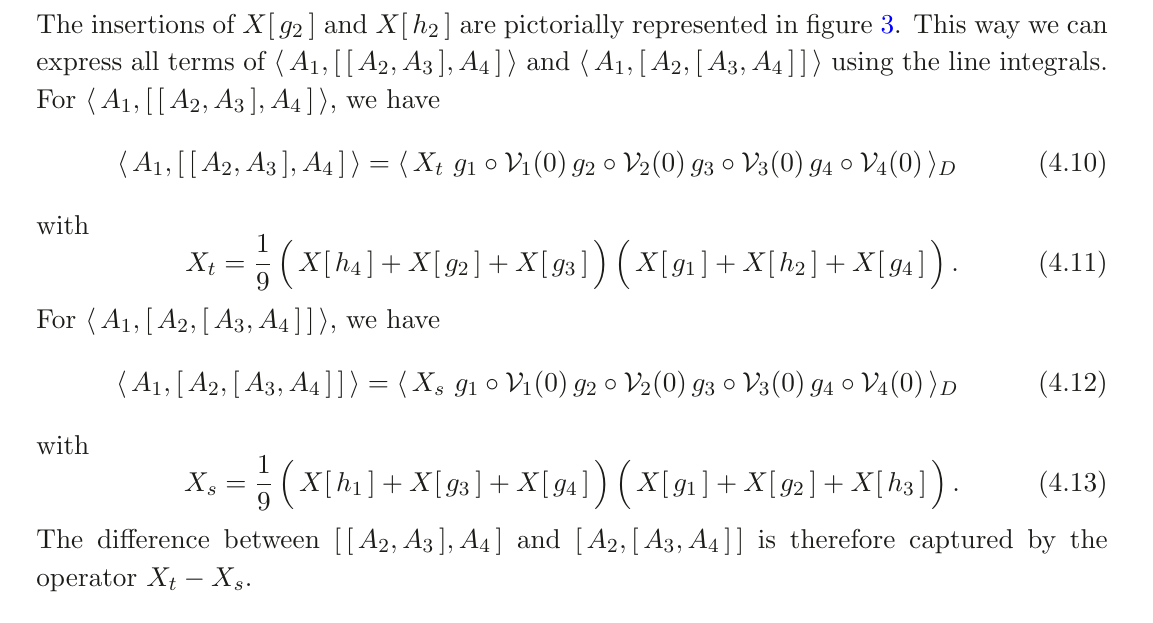
Figure 3 . A pictorial representation of X [ g 2 ] and X [ h 2 ] in (4.9). The blue line represents X [ g 2 ] and the orange line is for X [ h 2